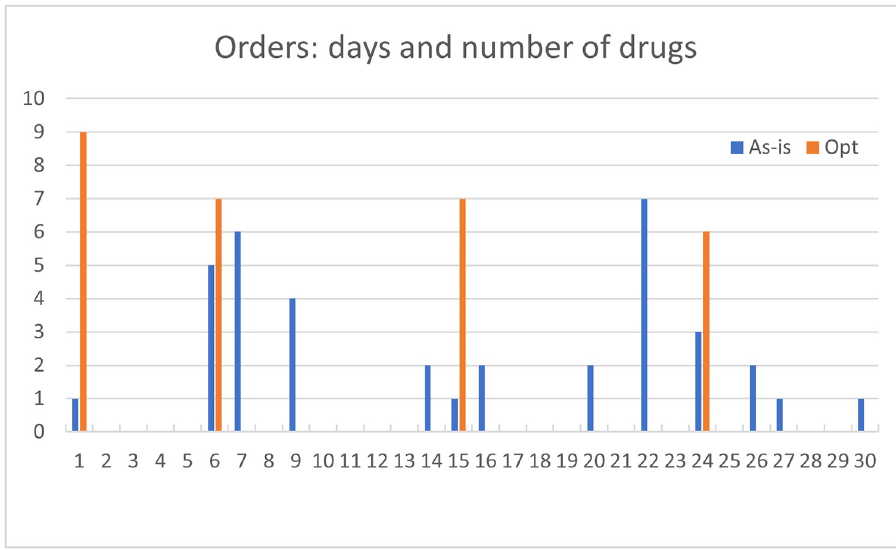
Fig 5. Order information: The as-is scenario vs optimization (June